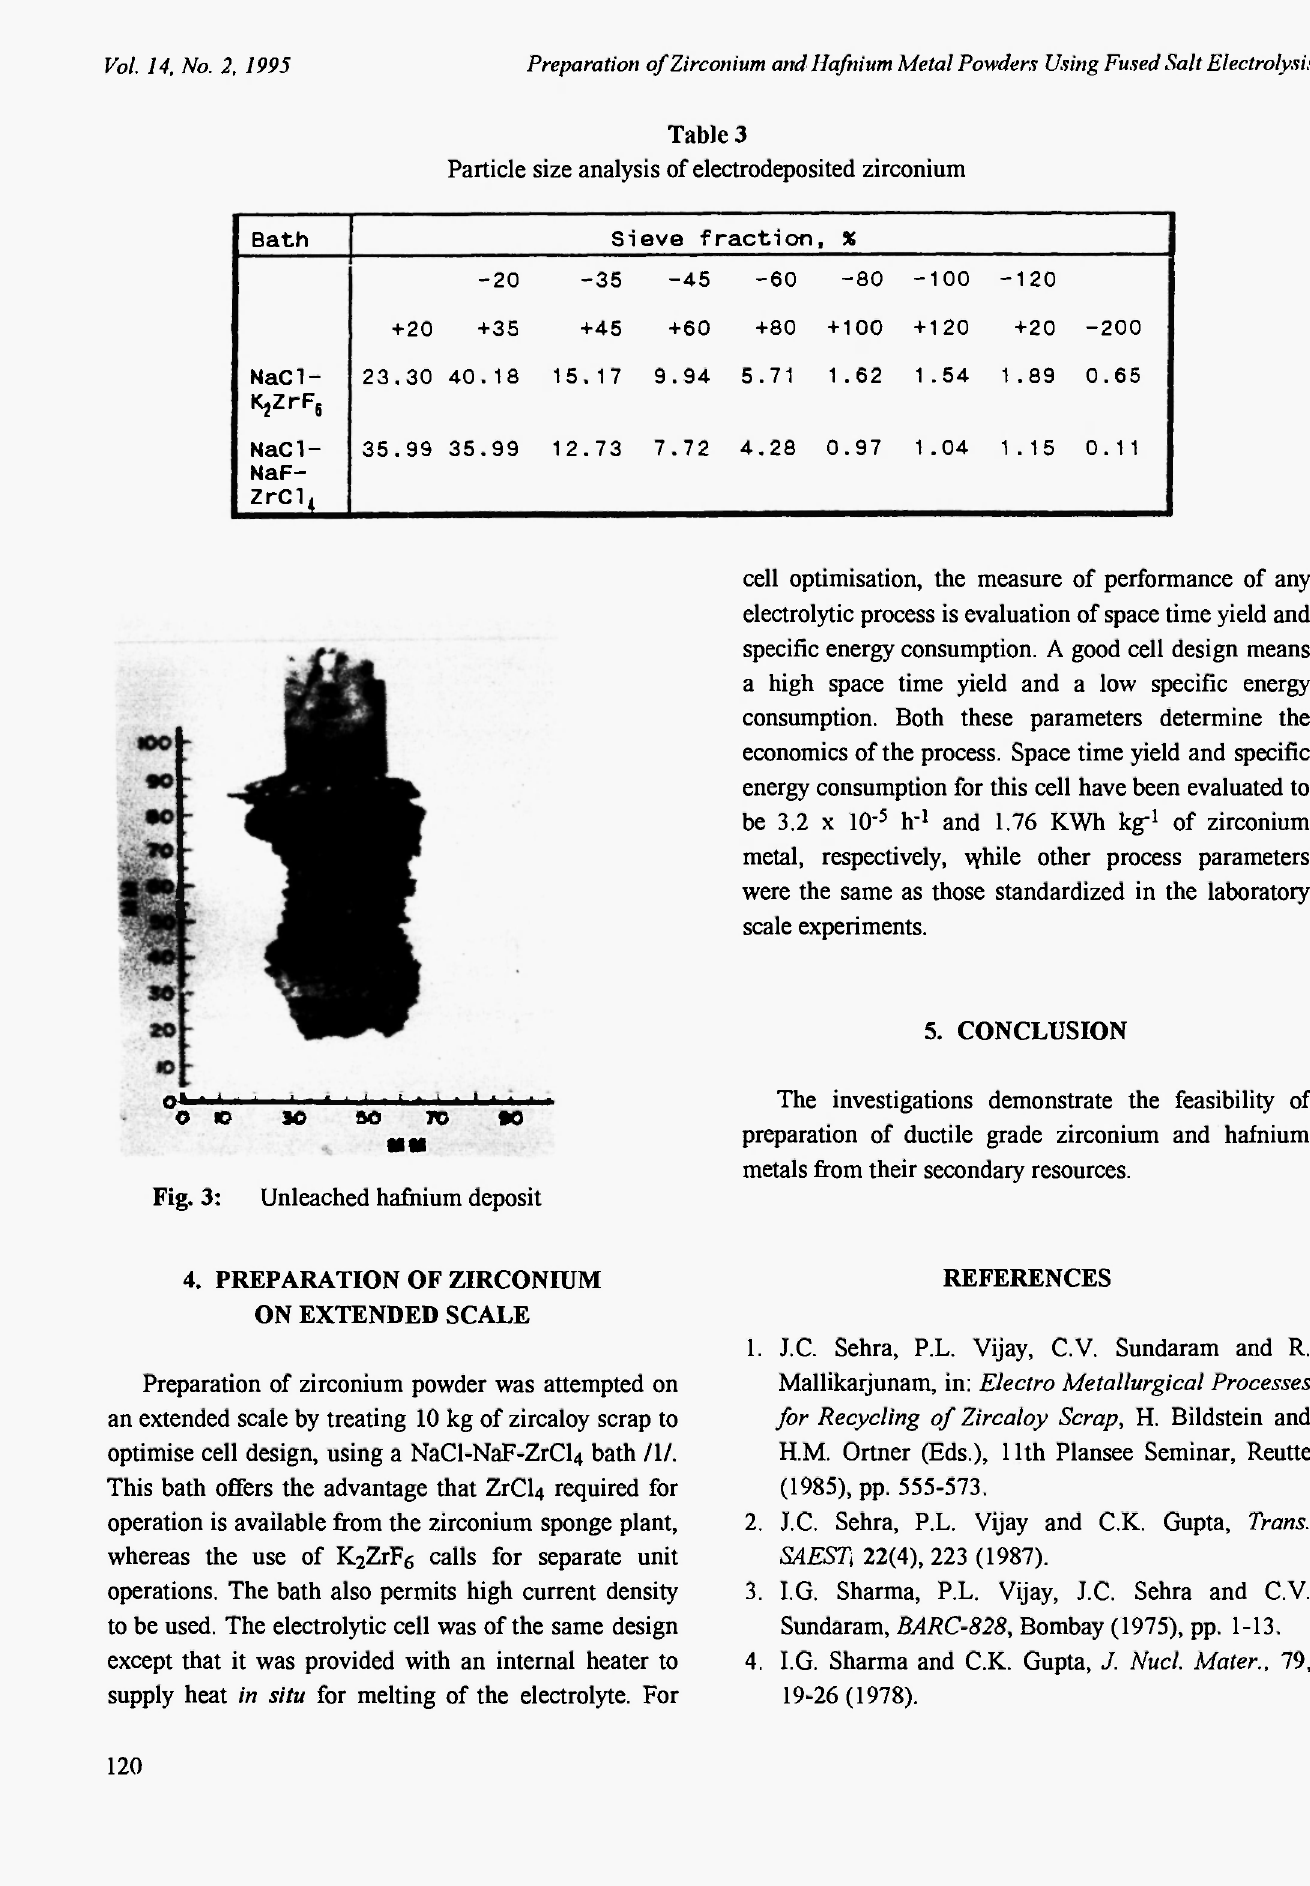
Particle size analysis of electrodeposited zirconium